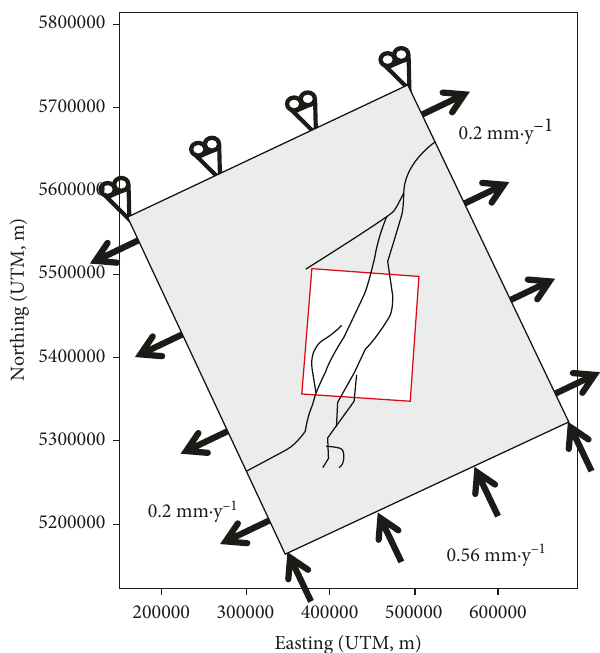
Figure 6: Far- fi eld displacements and embedding model (grey) for setting the faulted model (red frame) boundary conditions. Modi fi ed after Buchmann and Connolly [62]. UTM: Universal Transverse